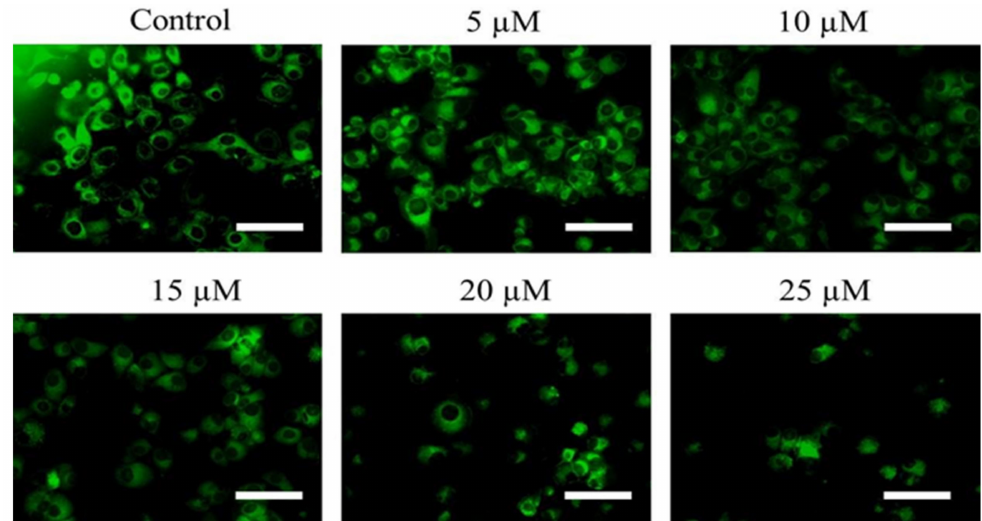
Figure 3. Dissipation of mitochondrial membrane potential ( ∆Ψ m) in PC-3 cells post treatment with various Cur-B concentration as assessed through Rh123 stain. Scale bar = 100 µ m.